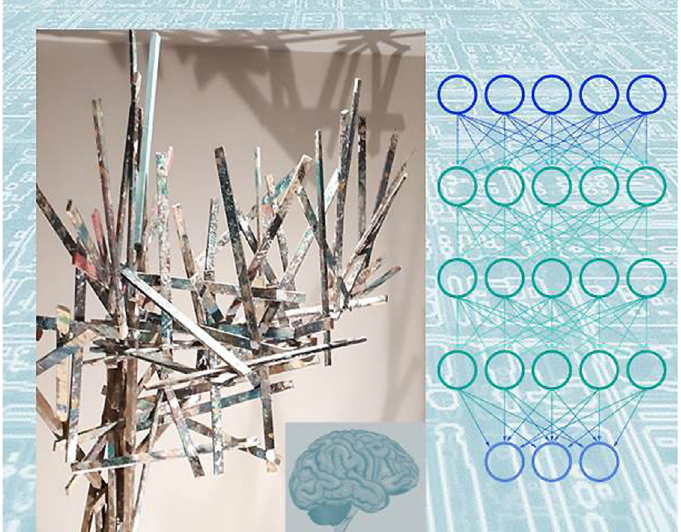
Figure 1. From brain convolutions to circuits through artificial neural networks. The brain is a complex neural network. The colored bars in the center brownish panel exemplify different architectures of algorithms (schematized on the right) at the interface of brain convolutions (small inset) and circuits (background light blue panel). Algorithms in artificial neural networks can be exploited